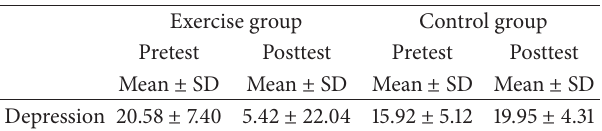
Table 5: Pretest and posttest mean and standard deviations of depression.